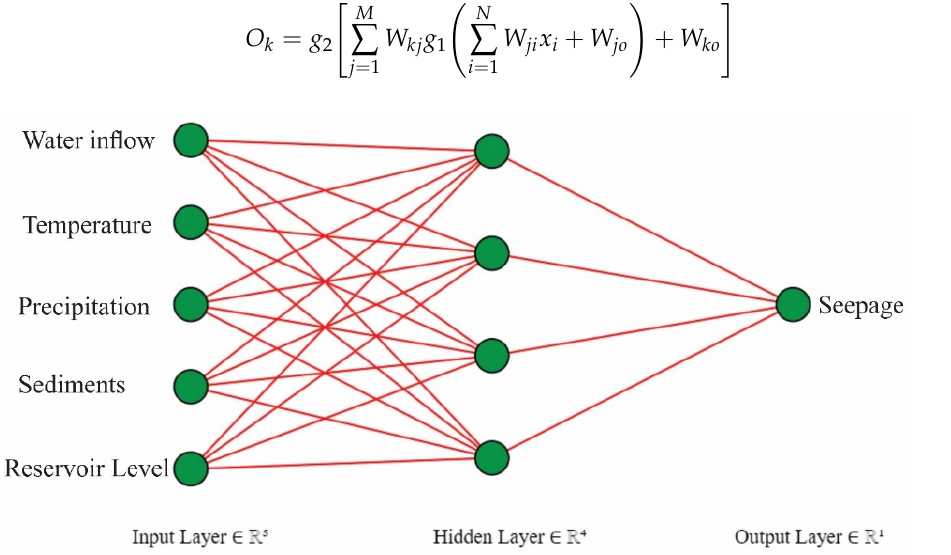
Figure 3. Artificial Neural Network (ANN) Architecture for hydro-climatological variable prediction schema.